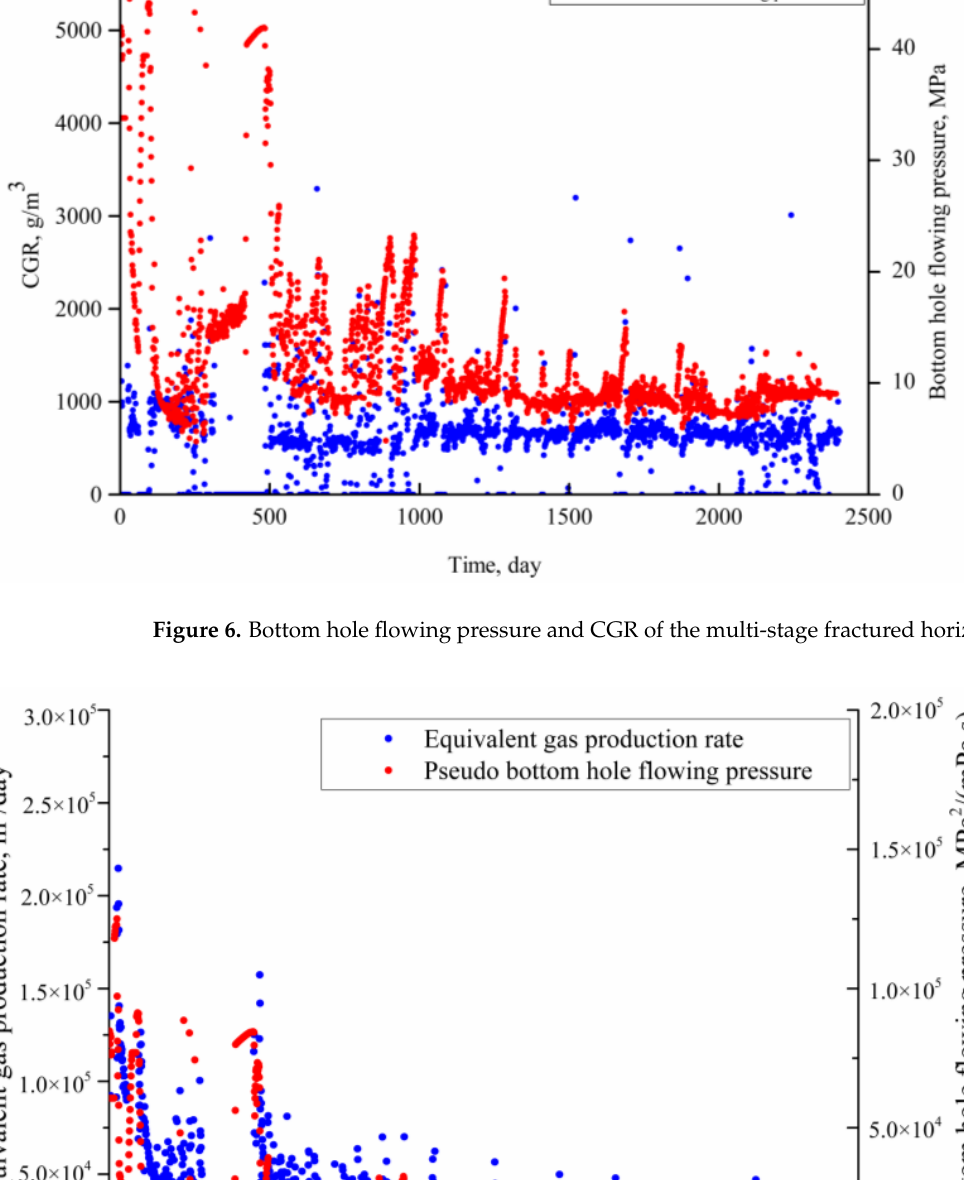
Figure 5. Pseudo bottom hole flowing pressure vs. bottom hole flowing pressure curve.